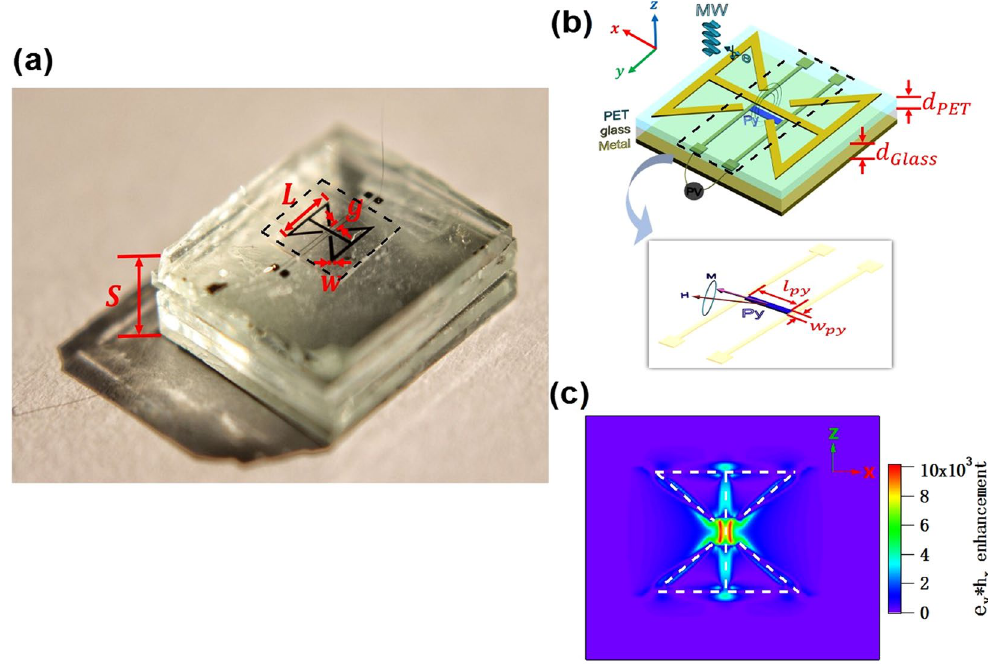
Figure 1. Schematic structure of the plasmonic diabolo cavity (PDC) and the simulation results. ( a ) Actual sample in our experiment, where the thickness of the cavity, S , was tunable. Typical dimension of MDA: L = 3 mm, w = 0.2 mm, and g = 0.5 mm. ( b ) Schematic diagram of the PDC, which contains three